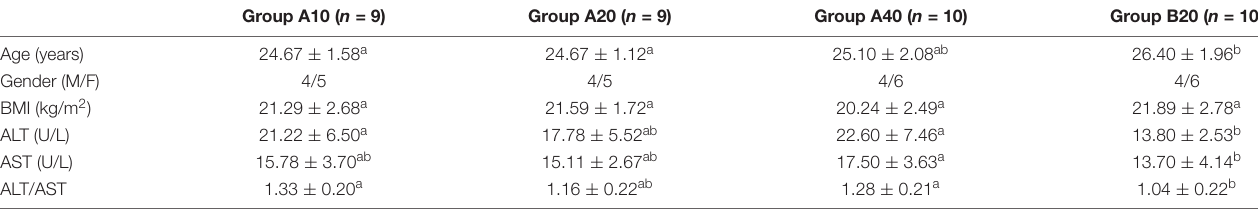
TABLE 1 | Baseline characteristics of the included